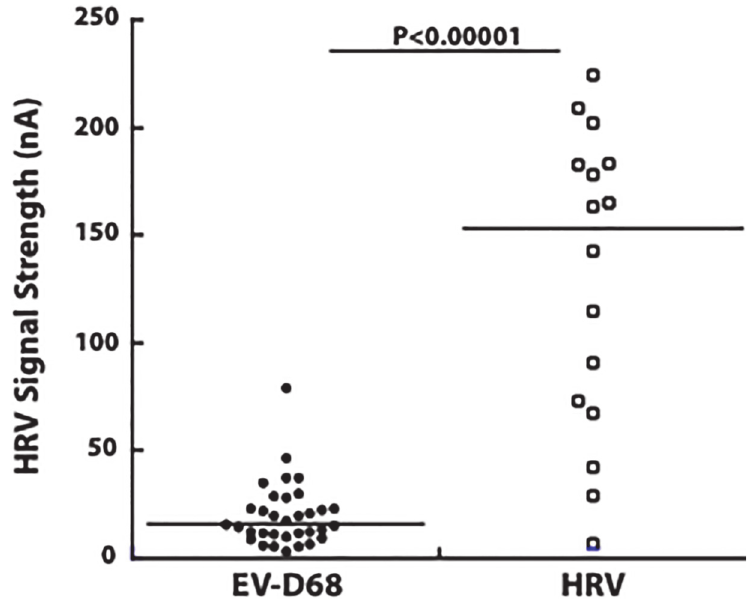
Fig 3. GenMark eSensor RVP signal strength for HRV in samples stratified by sequence results. Un- masking of the RVP results for all 62 samples revealed that the 49 positive PCR amplicons identified were derived from those samples that were also positive for HRV on the GenMark panel. Sequencing of these amplicons revealed that 33 were EV-D68 and 16 were HRV. The mean signal strength in nA of the RVP results for those samples identified as EV-D68 was significantly lower than for the HRV samples (20.3 nA versus 129.7 nA, respectively, p < 0.00001).